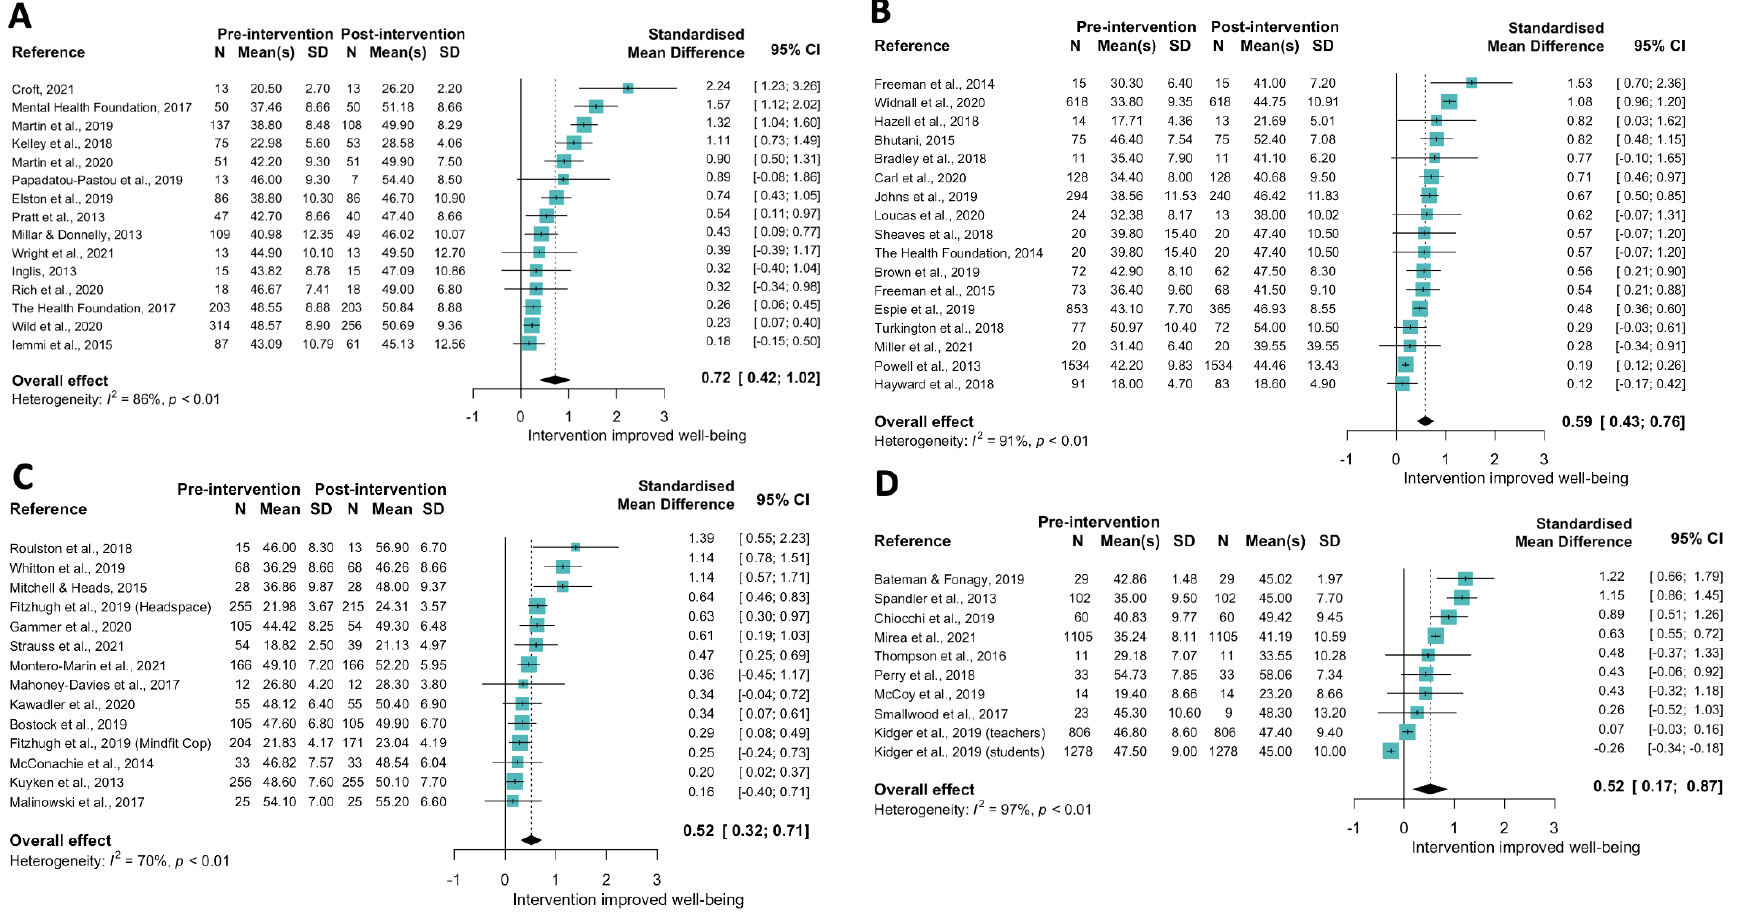
Figure 3. Forest plot indicating change in WEMWBS score (standardised mean difference) from pre to post intervention for the Psychological theme for ( A ). Resilience, self-management and wellness; ( B ). Cognitive behavioural therapy; ( C ). Mindfulness; and ( D ). Psychoeducation interventions [21 – 29,31 – 33,36 – 38,40,41,43 – 48,50 – 76,78 – 81].